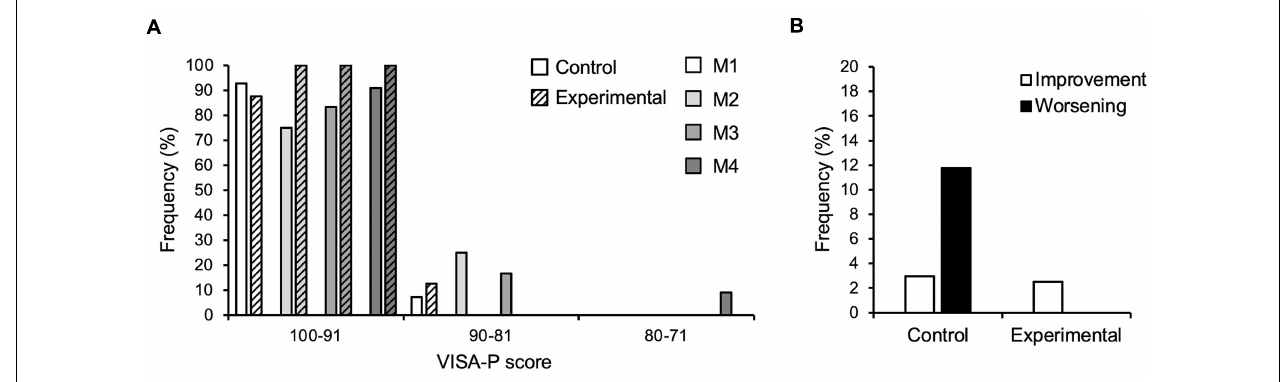
FIGURE 2 | (A) Frequency of athletes reporting respective VISA-P scores in 10-point-intervals at the four measurement time points (M1-4) over the season in the control ( n = 15) and experimental group ( n = 16; hatched bars). (B) Frequency of clinically significant improvement or worsening (i.e., ± 13 points of the VISA-P score) considering all observations in the control ( n = 49) and experimental group ( n = 56), respectively. Note that not all participants were able to attend all